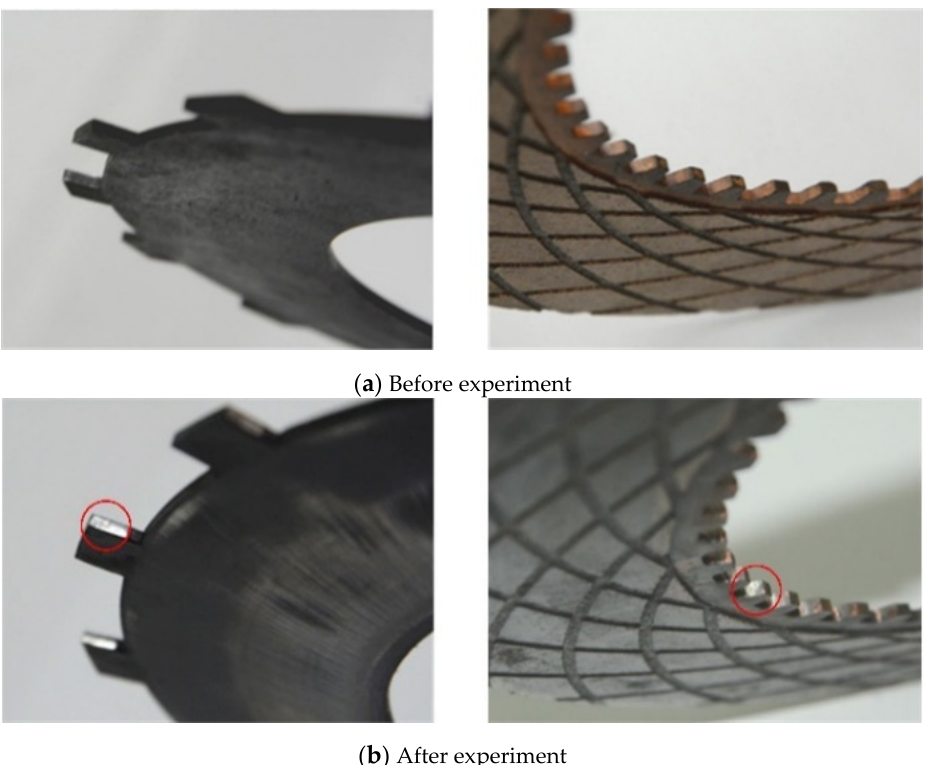
Figure 1. Wear of the spline teeth.